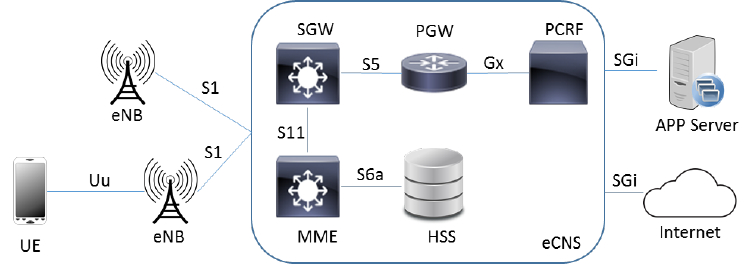
Figure A1. General scheme of the LTE network deployed at the University of